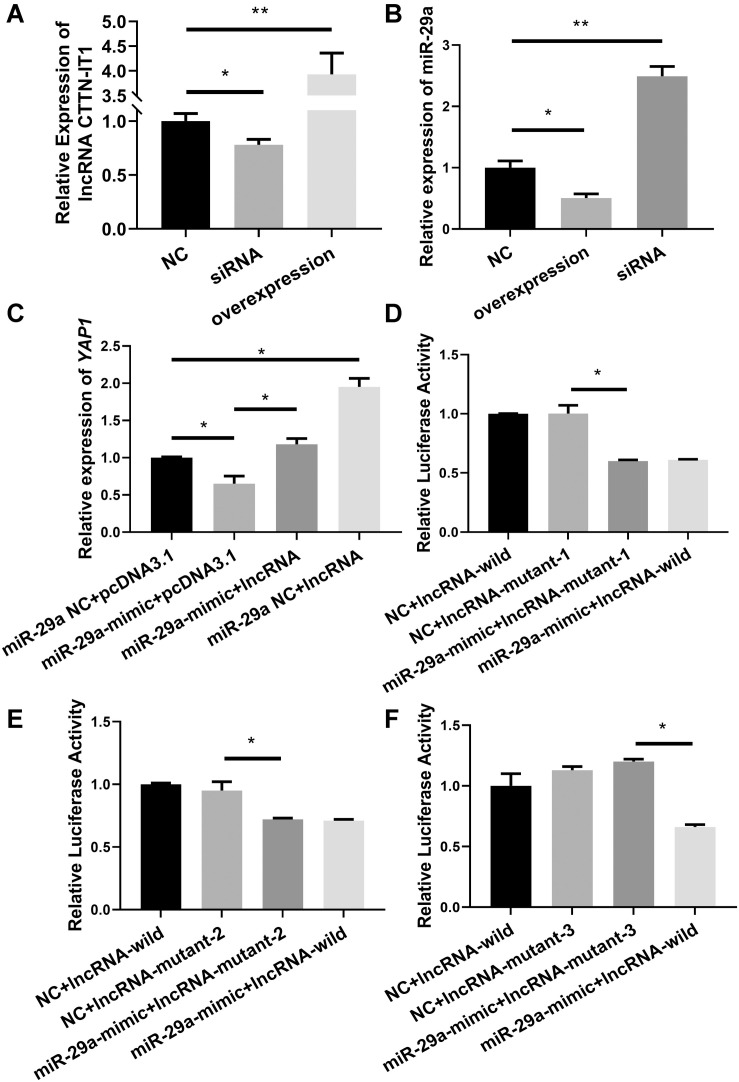
Verification of target regulation relationship between miR-29a and CTTN-IT1. (A) The relative expression level of CTTN-IT1 after overexpression or interference of CTTN-IT1 in SMSCs. (B) The relative expression level of miR-29a after overexpression or interference of CTTN-IT1 in SMSCs. (C) The relative expression level of YAP1 after lncRNA-overexpression plasmid [pcDNA3.1(+) used as Blank] was co-transfected with miR-29a mimic or miR-29a mimic-NC into SMSCs. (D–F) These three figures are the results of dual-luciferase reporter assay. Relative luciferase activity was assessed after co-transfecting the miR-29a mimic (miR-29a mimic-NC used as Blank) with the wild or the mutant plasmids of CTTN-IT1 into HEK293T cells. Mutant plasmids of three different binding sites listed in Table 3 were used in figures (D–F), respectively. The “lncRNA” in C means the transfection of lncRNA-overexpression plasmid. *P < 0.05 or **P < 0.01.